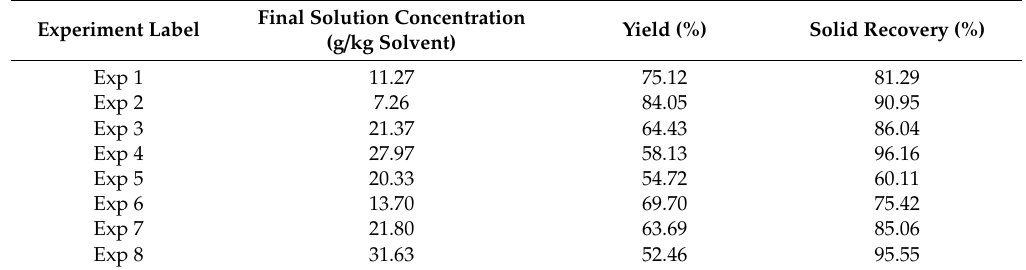
Table 2. Yield and solid recovery values for the antisolvent crystallisation experiments. Experiment